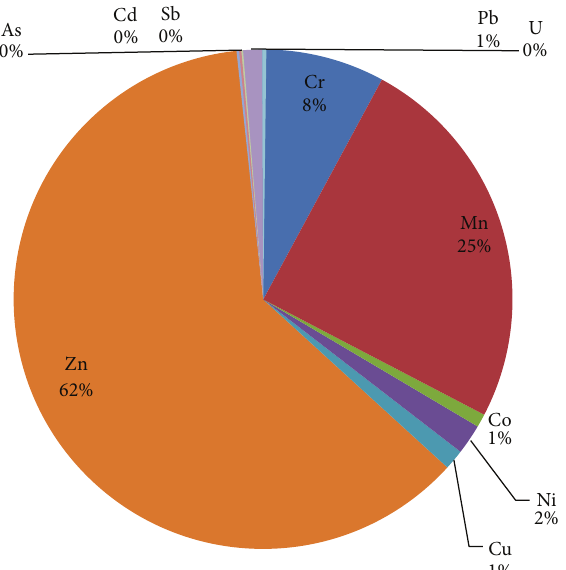
Figure 1: Distribution of trace metals in dust samples collected from School A.